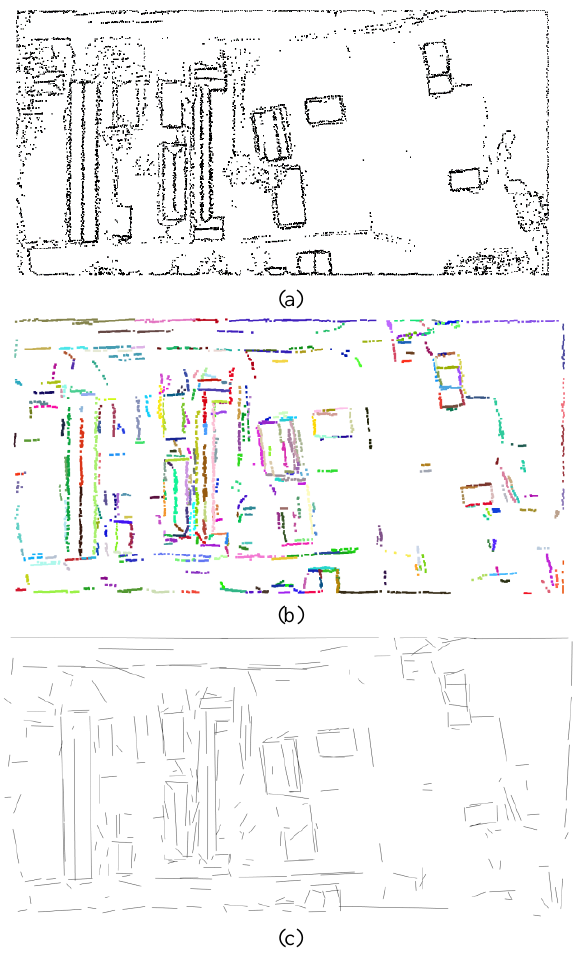
Figure 7. The results of straight line segment extraction for the testing area in the first dataset, (a) is the 3D-edges detected by AGPN, (b) is the traced feature lines, (c) is the extracted straight line